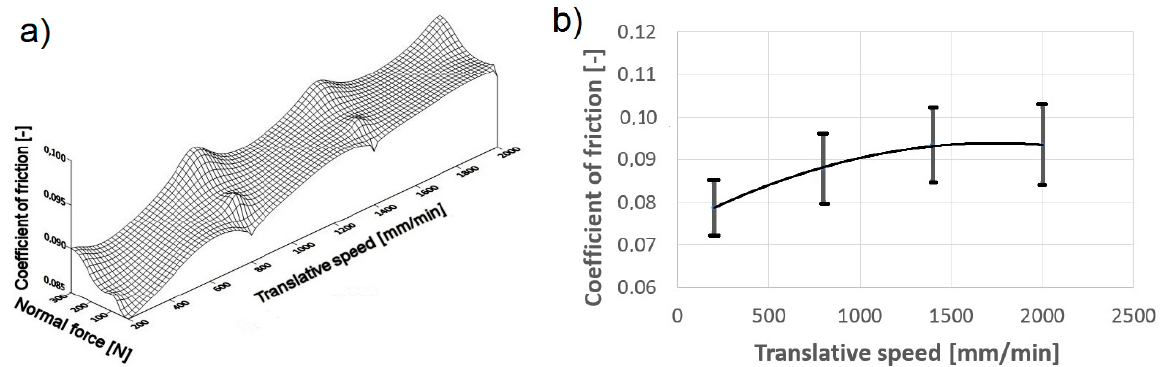
Figure 25. The tribological results for the coefficient of friction. ( a ) the effect of normal force and